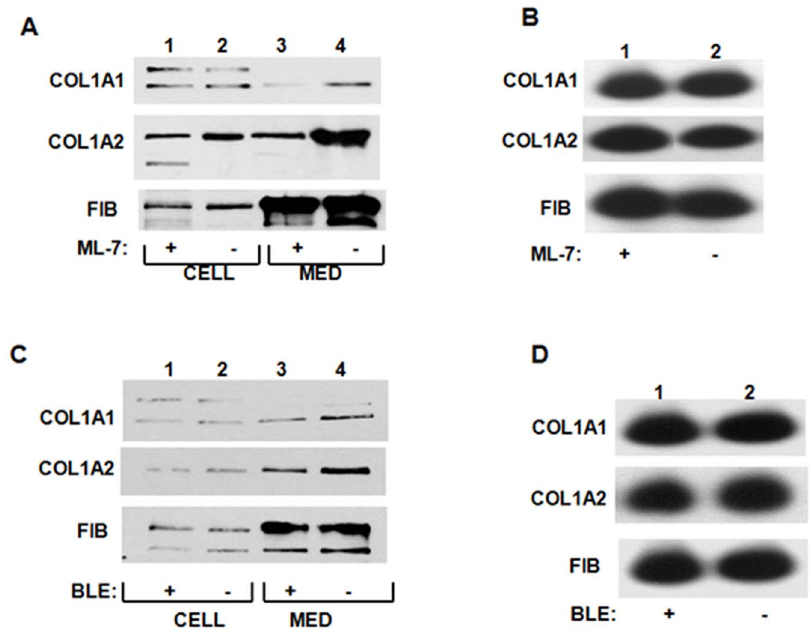
Figure 4. Disruption of nonmuscle myosin filaments decreases type I collagen production. A. Effect of ML-7. HLFs were treated with ML-7 and the level of collagen polypeptides intracellularly (lanes 1 and 2) or secreted into the culture medium (lanes 3 and 4) was analyzed by western blot. Loading control: fibronectin (FIB). B. ML-7 does not affect expression of collagen mRNAs. Total RNA was extracted from cells in A and analyzed for expression of collagen and fibronectin mRNAs by RT-PCR. C. Effect of blebbistatin. Experiment as in A, except HLFs were treated with blebbistatin. D. Expression of collagen mRNAs in cells treated with blebbistatin. Experiment as in C, except the cells were treated with blebbistatin.